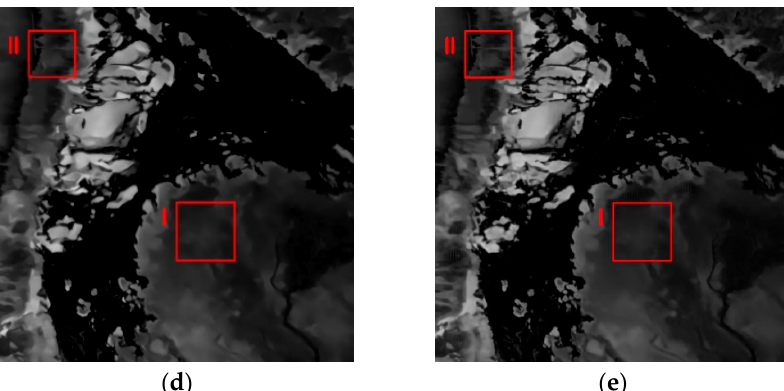
Figure 11. Despeckle results of different methods for the Death Valley SAR image: ( a ) original; ( b ) PPB; ( c ) SAR-BM3D; ( d ) ID-CNN; ( e ) proposed.